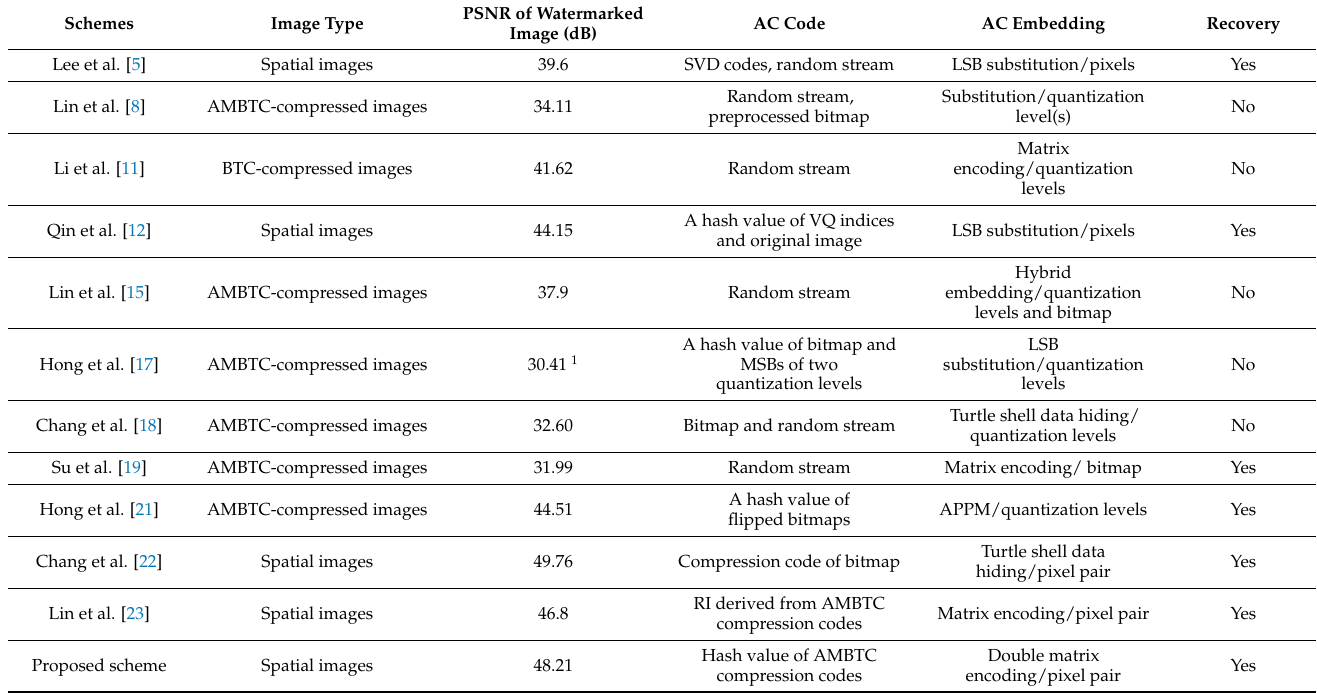
Table 9. Comparison between proposed and other BTC/AMBTC/VQ-based fragile watermarking